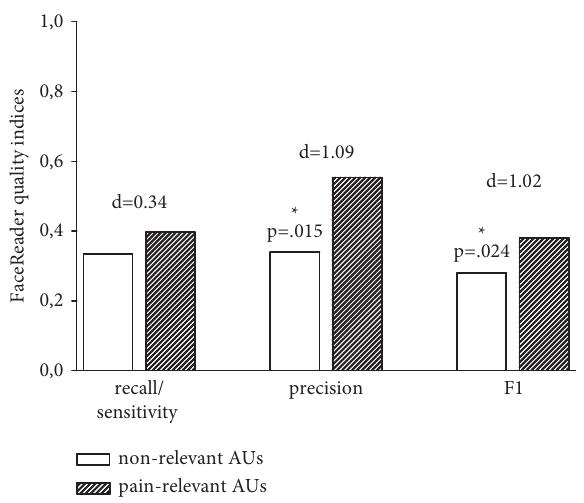
Figure 1: FaceReader7 performance in dependence of whether AU is pain-relevant or nonrelevant. Nonrelevant AUs: AU1, AU2, AU5, AU12, AU14, AU15, AU17, AU18, AU20, AU23, AU24. Pain-relevant AUs: AU4, AU6, AU7, AU9, AU10, AU25, AU26, AU27, and AU43. ∗ p < 0 . 05; d � effect size, Cohen ’ s d .